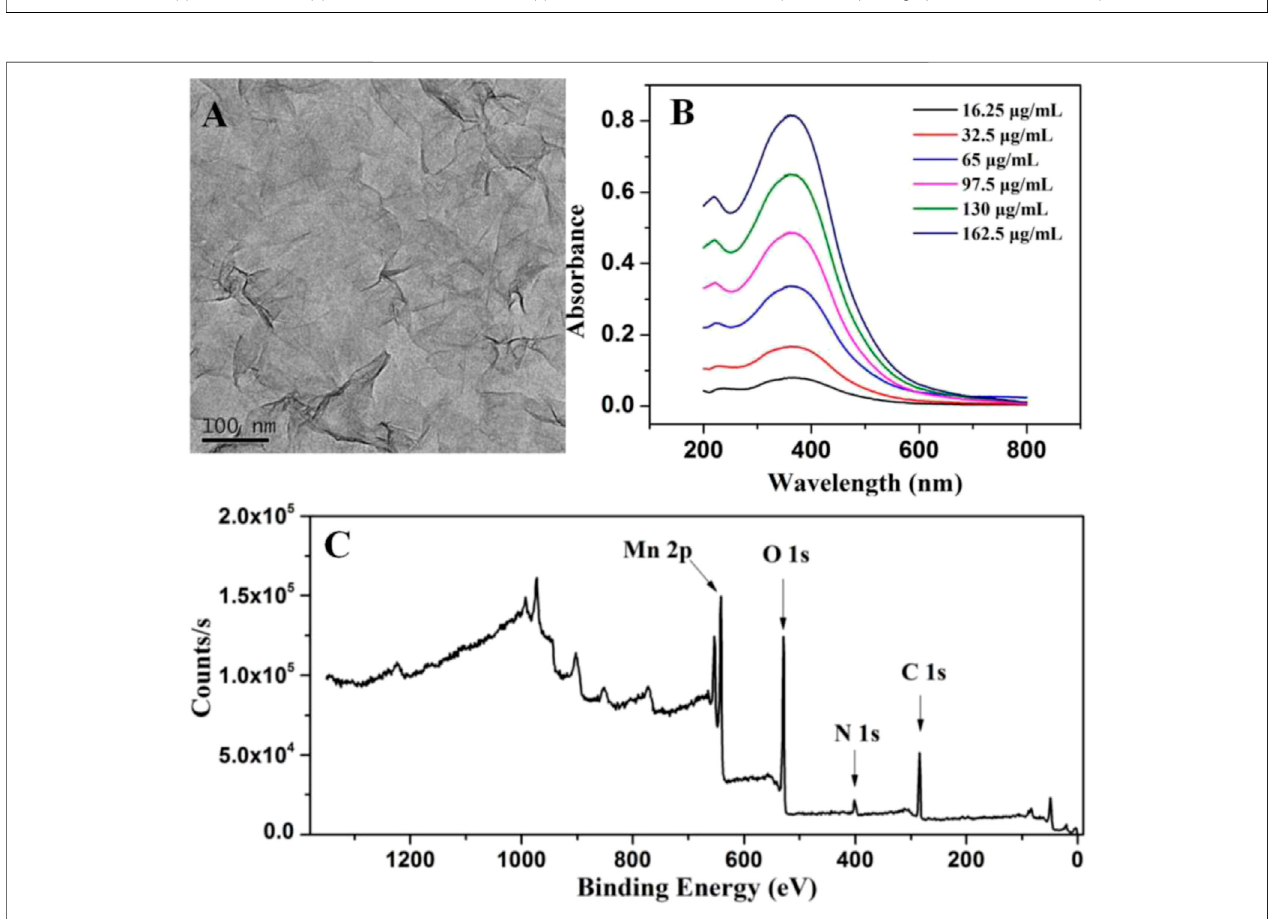
FIGURE 2 | (A) TEM photograph of MnO 2 NSs (B) Absorption spectra of different concentrations of MnO 2 NSs (C) XPS characterization of MnO 2 NSs.